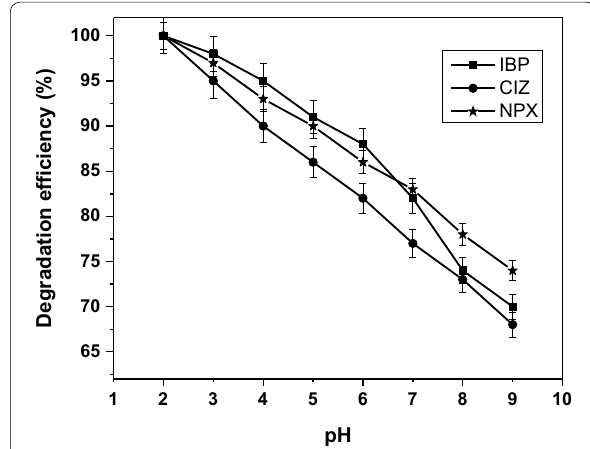
Fig. 4 Effect of the pH on the degradation efficiency for IBP, NPX, and CIZ at initial concentration of 5 mg/L, drug solution volume of 100 mL, and irradiation time of IBP CIZ 25 min =